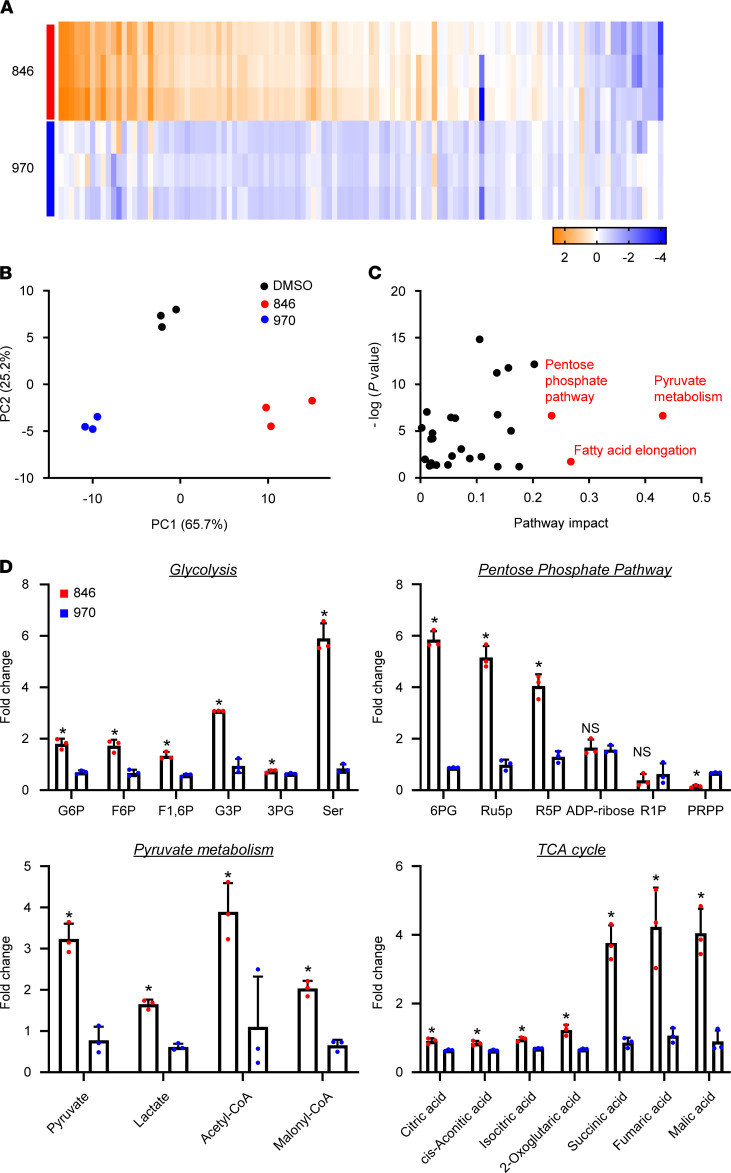
Metabolomic alterations associated with administration of TNIK inhibitor in OS cells.(A) Heatmap of 115 intracellular metabolites of U2OS cells treated with 1 μM NCB-0846 (846) or 1 μM NCB-0970 (970) for 72 hours. Relative concentrations or ratios of metabolites in U2OS cells treated with NCB-0846 or NCB-0970 were analyzed. The mean metabolite concentration in U2OS cells treated with DMSO was set as 1, and log2 values are depicted as a color scale (n = 3 per group). (B) Principal component analysis of metabolites of U2OS cells treated with DMSO (vehicle) (black), 1 μM NCB-0846 (red), or 1 μM NCB-0970 (blue) for 72 hours. (C) Pathway analysis showing high-impact alterations of the pentose phosphate, pyruvate metabolism, and fatty acid elongation pathways by NCB-0846. (D) Relative concentrations of metabolites involved in glycolysis, the pentose phosphate pathway, pyruvate metabolism/lipid synthesis, and the TCA cycle in U2OS cells treated in triplicate with 1 μM NCB-0846 (red) or 1 μM NCB-0970 (blue) for 72 hours. The mean metabolite concentration in U2OS cells treated with DMSO was set as 1. The complete metabolome data are available in Supplemental Table 3. L/P, lactate/pyruvate. Welch’s t test, *P < 0.05 compared with NCB-0970.